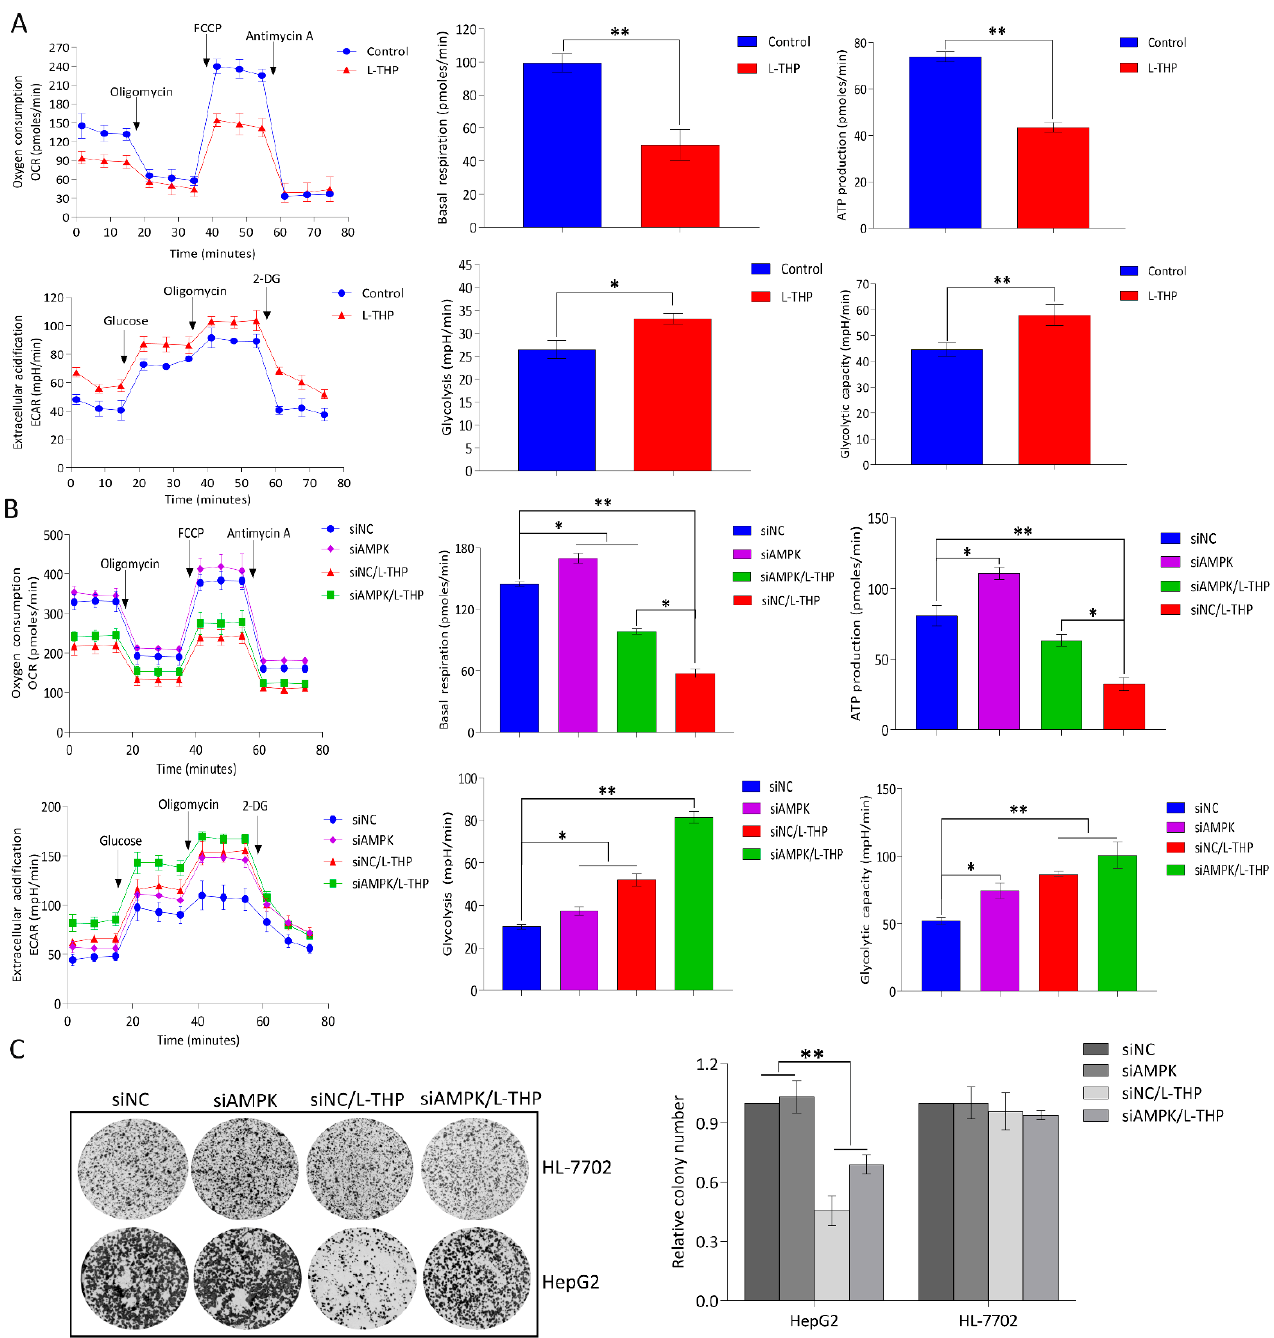
Figure 4. l-THP treatment leads to decreased OXPHOS and increased glycolysis in HepG2 cells. ( A ) The basal respiration level and ATP production rate in OCR as well as the glycolysis and glycolytic capacity in ECAR were examined using the Seahorse XFp analyzer. ( B ) OCR and ECAR were evaluated in HepG2 cells after silencing AMPK. ( C ) Colony formation assays were performed to assess the ability of l-THP to inhibit the growth of HepG2 siAMPK+/ − and HL-7702 cells. Quantitative data are expressed as the mean ± SD of three independent experiments ( n = 3). * p < 0.05 and ** p < 0.01 are considered to be statistically significant compared to the control.